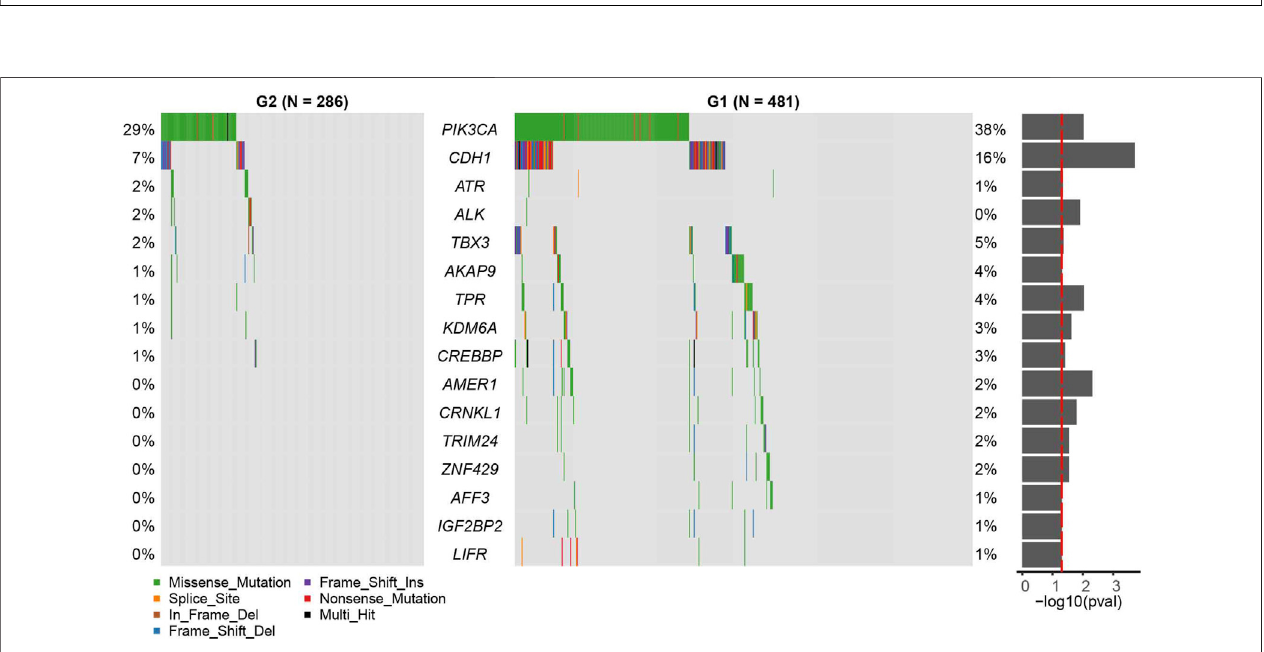
FIGURE 3 | Census mutation landscape between group 2 (G2) and group 1 (G1). Only cancer census genes in the COSMIC database are shown in the plot. The signi fi cance of the difference in gene mutation frequency between the two groups is shown in the barplot on the right ( fi sher ’ s exact test).